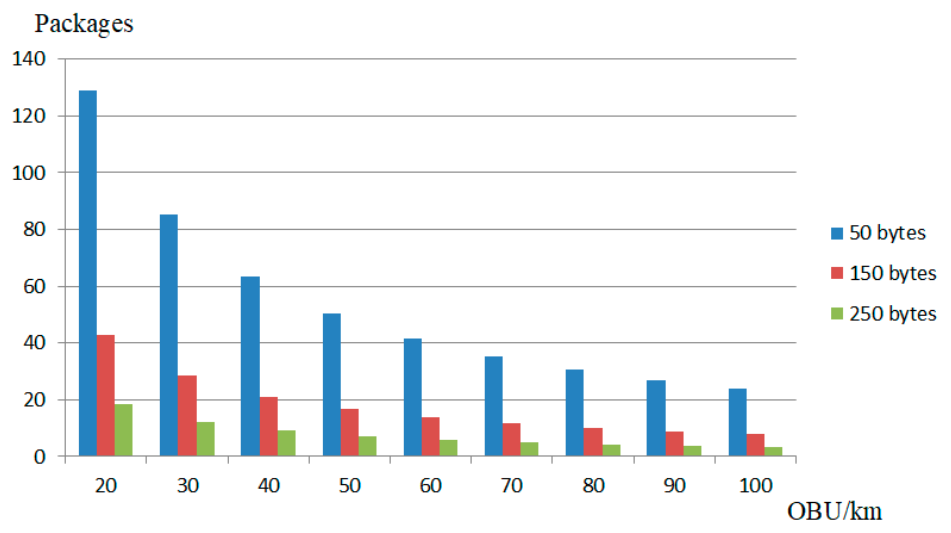
Figure 6. Dependence of the average number of packets per OBU on road traffic intensity with a minimal level of confidentiality and a 64-bit protocol.